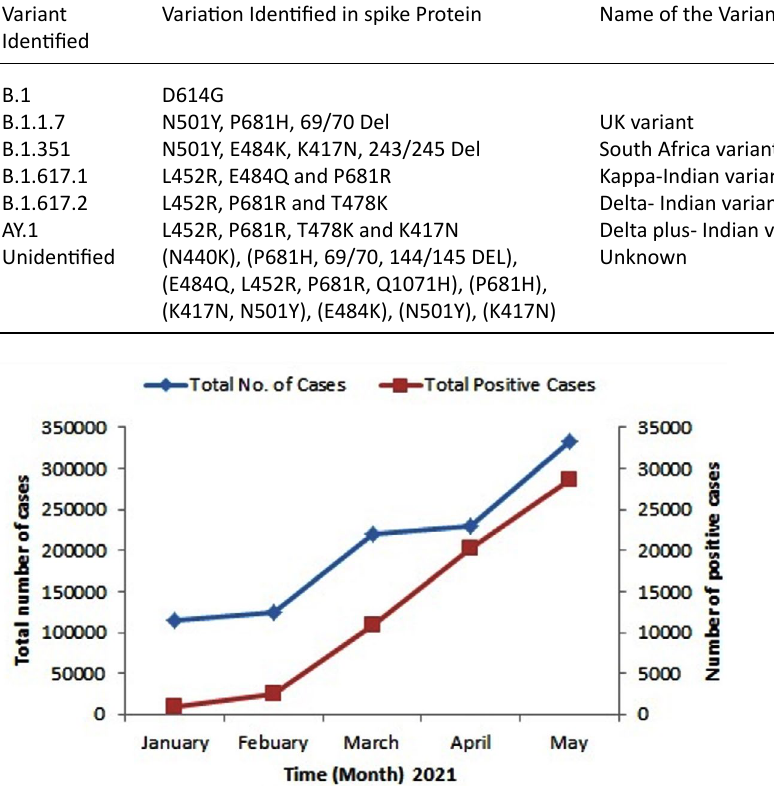
Fig. 1. Trends in the distribution of positivity as compared to total sample during the second wave in time period of January 2021 to May 2021. New cases in 5 districts of Punjab are rapidly on the rise since February reaching a peak of approx. about 35, 0000 among which there is upsurge of positive cases every